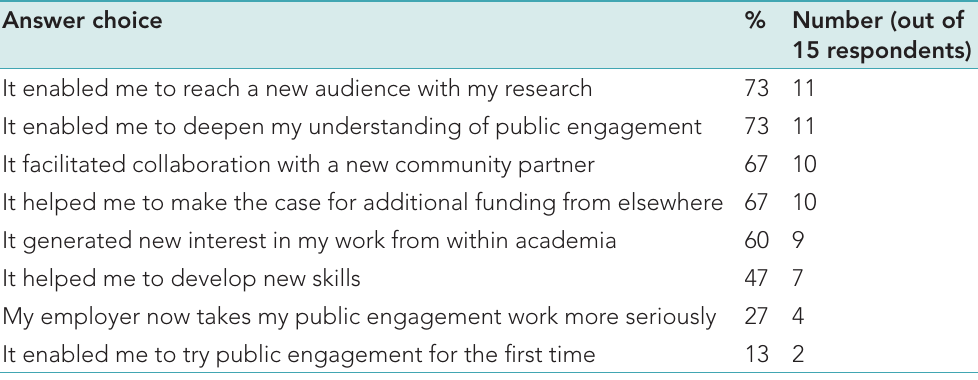
Table 1: Responses to the question, ‘In what ways has the ICS public